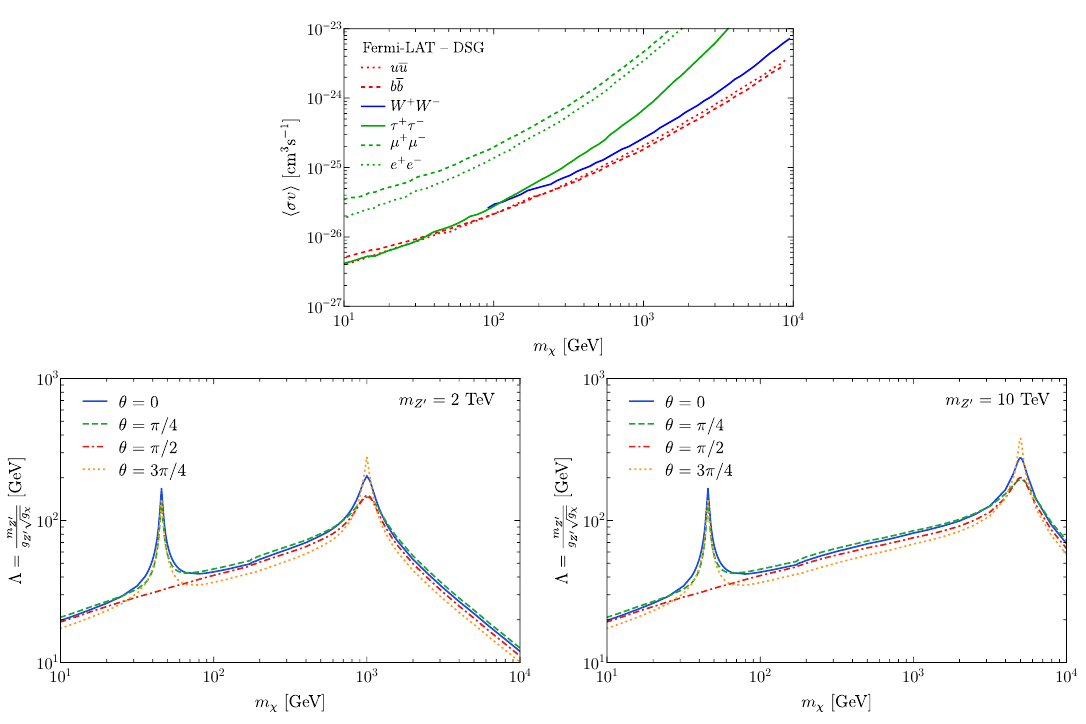
Figure 4 . ( Replaces (cid:12)gure 5 of the original paper .) Top : bounds on vations of dSph, assuming 100% BR in the channels shown in the legend. Bottom : bounds on from Fermi-LAT observations of dSph in our model, for the four values of (cid:18) we have chosen, and for m Z 0 = 2 TeV ( left ) and 10 TeV ( right